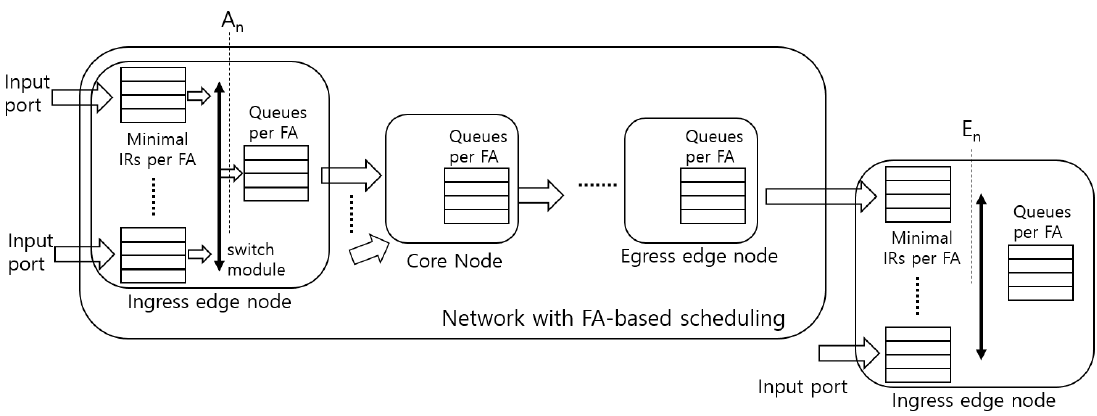
Figure 4. An implementation practice of the proposed delay guarantee framework.